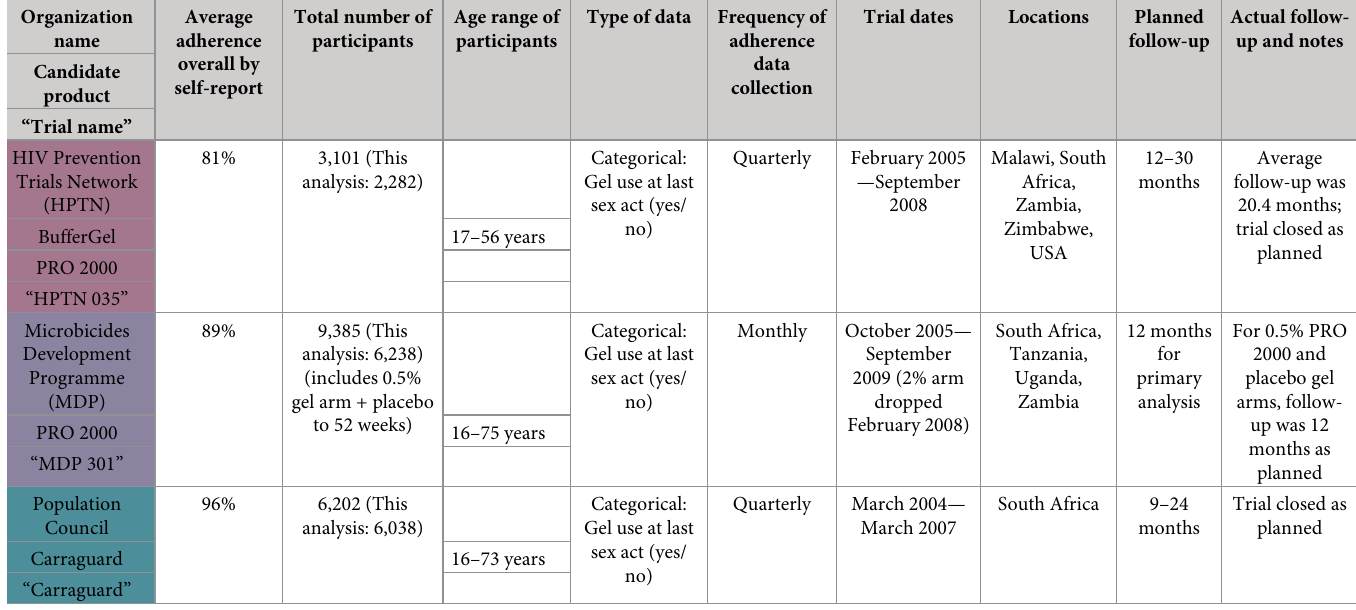
Table 1. Clinical trials included in the latent class